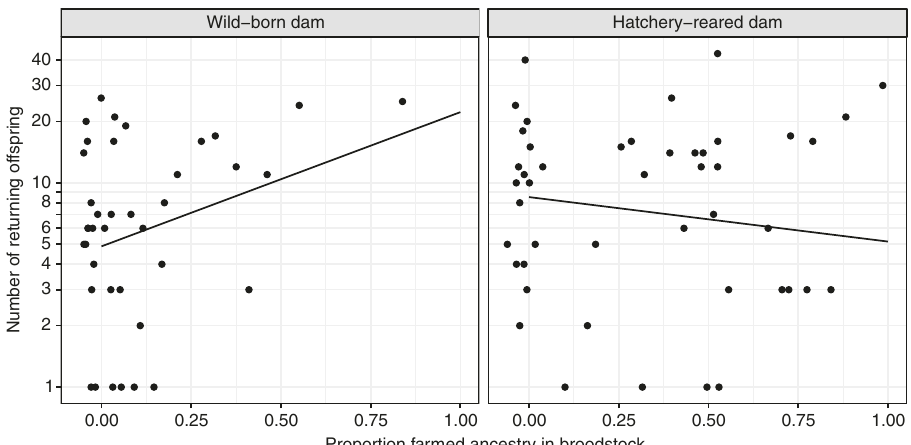
Fig. 1 Effect of introgression on the number of recaptured adult offspring from wild-born and hatchery-reared dams. Introgressed wild-born dams produce more recaptured adult offspring than wild-born dams with no farmed ancestry. Hatchery-reared dams produce more offspring than wild-born dams but show no response to introgression. Lines represent model predictions from least square regression. See Table 1 for parameter estimates. Source data are provided as a Source Data fi